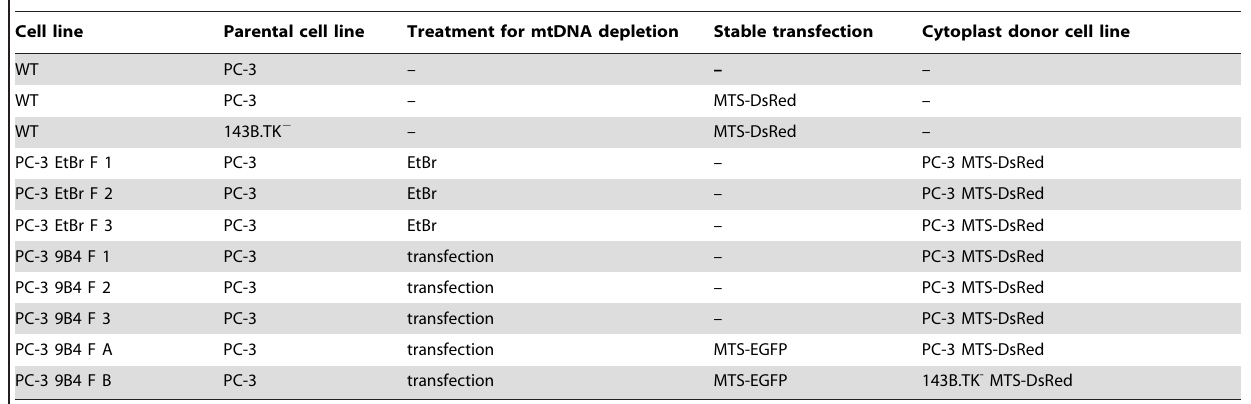
Table 1. Nomenclature of fusion cell lines.